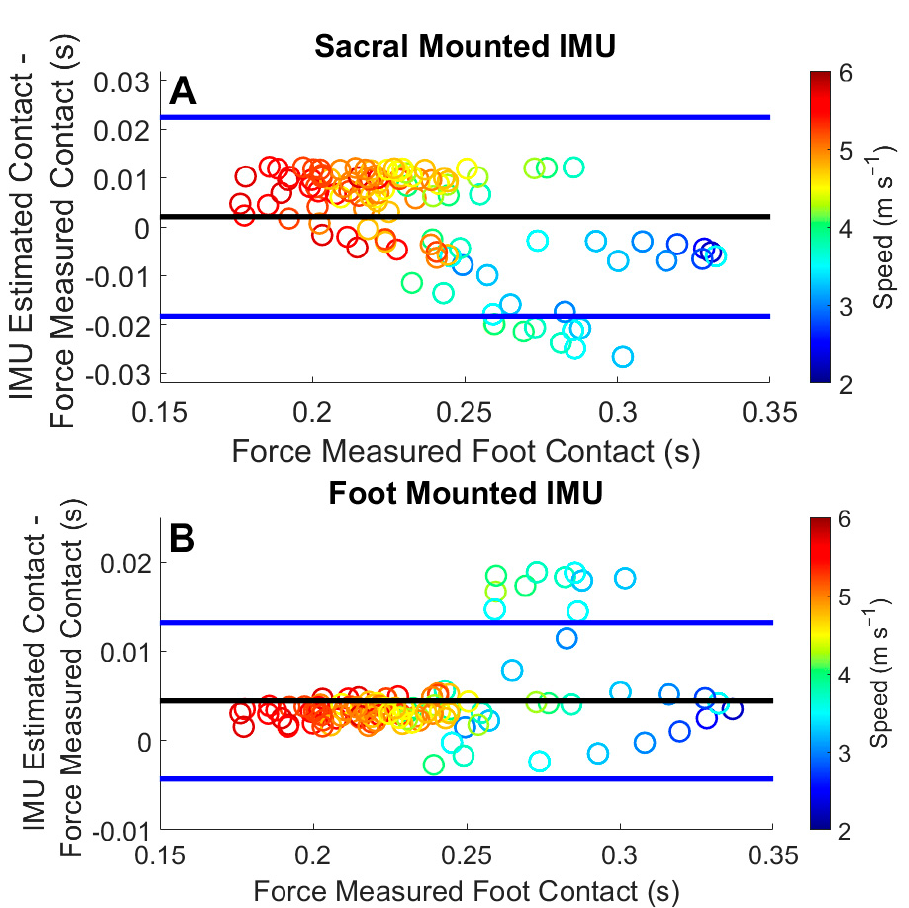
Figure 6. Bland–Altman plot displaying the average differences between the estimated contact durations from the IMUs and the measured gait events from the force-sensing insoles: ( A ) data from the sacral-mounted IMU; ( B ) data from the foot-mounted IMU. Each dot represents an average speed trial by a participant. Differences greater than 0 are an overestimation of contact time by the IMU. Differences less than 0 are an underestimation of foot contact by the